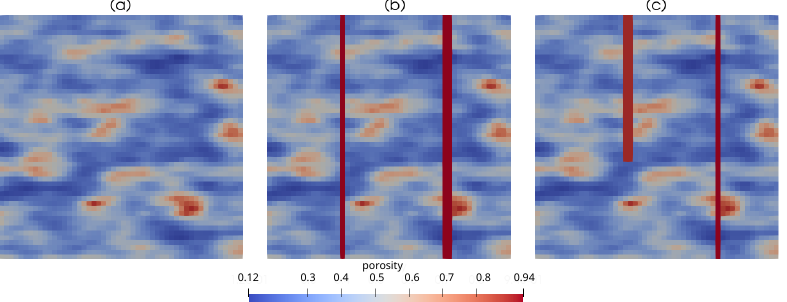
Figure 1. The porosity fields for the three investigated cases: ( a ) no macropores; ( b ) two macropores from top to bottom with different width; ( c ) two macropores with different porosity and different width, only one from top to bottom.